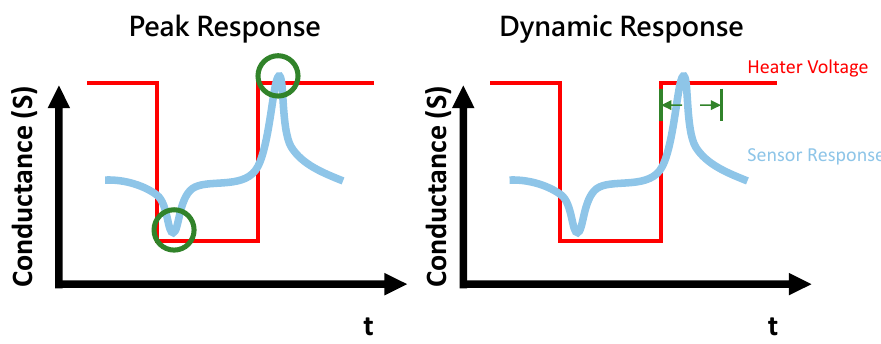
Figure 1. Di ff erent methods of extracting information from the temperature modulation. The red line denotes the heater voltage; the blue line denotes the response of the sensor; and the green line denotes the information extracted through di ff erent methods.